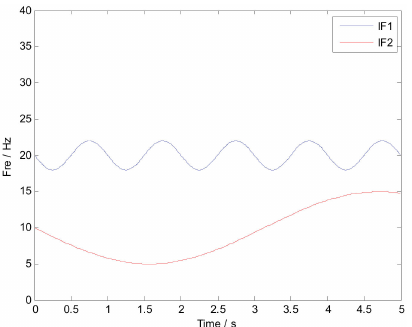
Figure 5. The ideal instantaneous frequency corresponding to IF 1 and IF 2 .